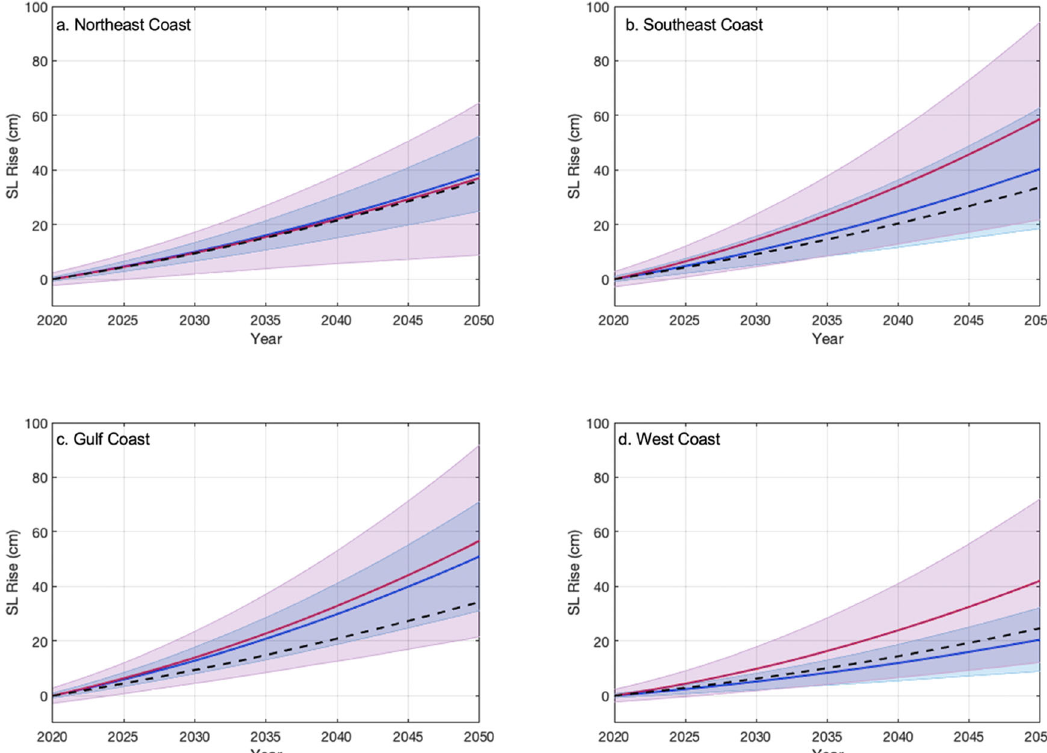
Fig. 5 Observation extrapolations, 2020-2050. Altimeter-based extrapolated trajectories. from 2020 to 2050 for four different regions along the coastlines of the United States: ( a ) Northeast Coast, ( b ) Southeast Coast, ( c ) Gulf Coast, ( d ) West Coast obtained using both the enveloping approach (red) and the approach of correcting for internal variability and accounting for serial correlation and altimeter measurement error (blue). The shaded regions bound the 90% con fi dence interval for the projections. Also shown are the projections (black dotted line) after adjusting the altimeter-measured trends using a correction based on the tide gauge acceleration and rate